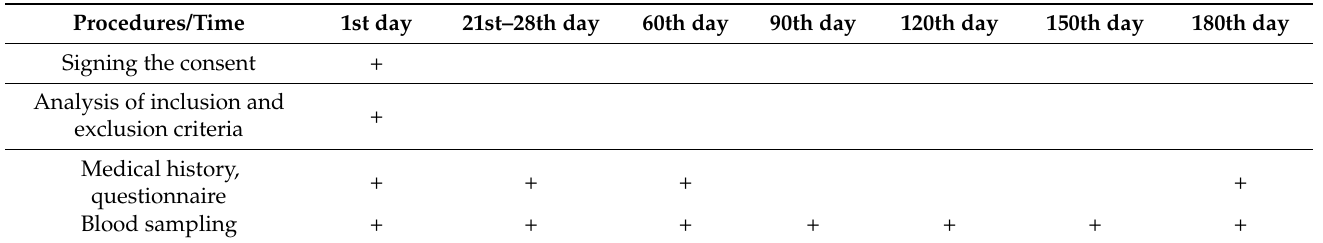
Table 1. Table detailing the timeline of procedures and laboratory workup in this